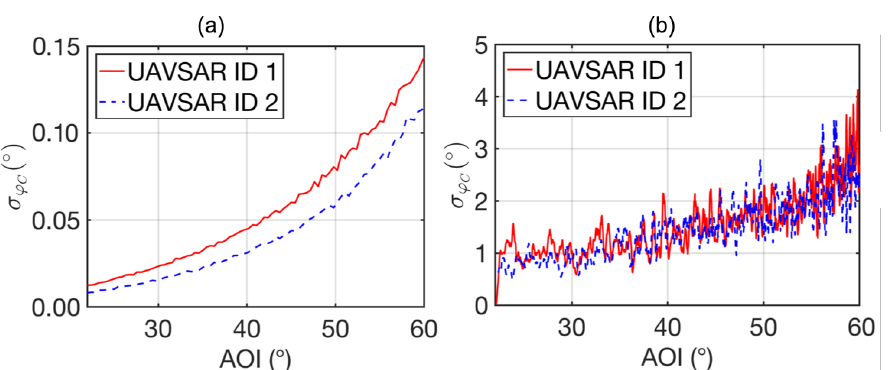
Figure 3. Simulated ( a ); and measured ( b ) behavior of σ ϕ scenes ID 1 (red line) and 2 (blue dashed